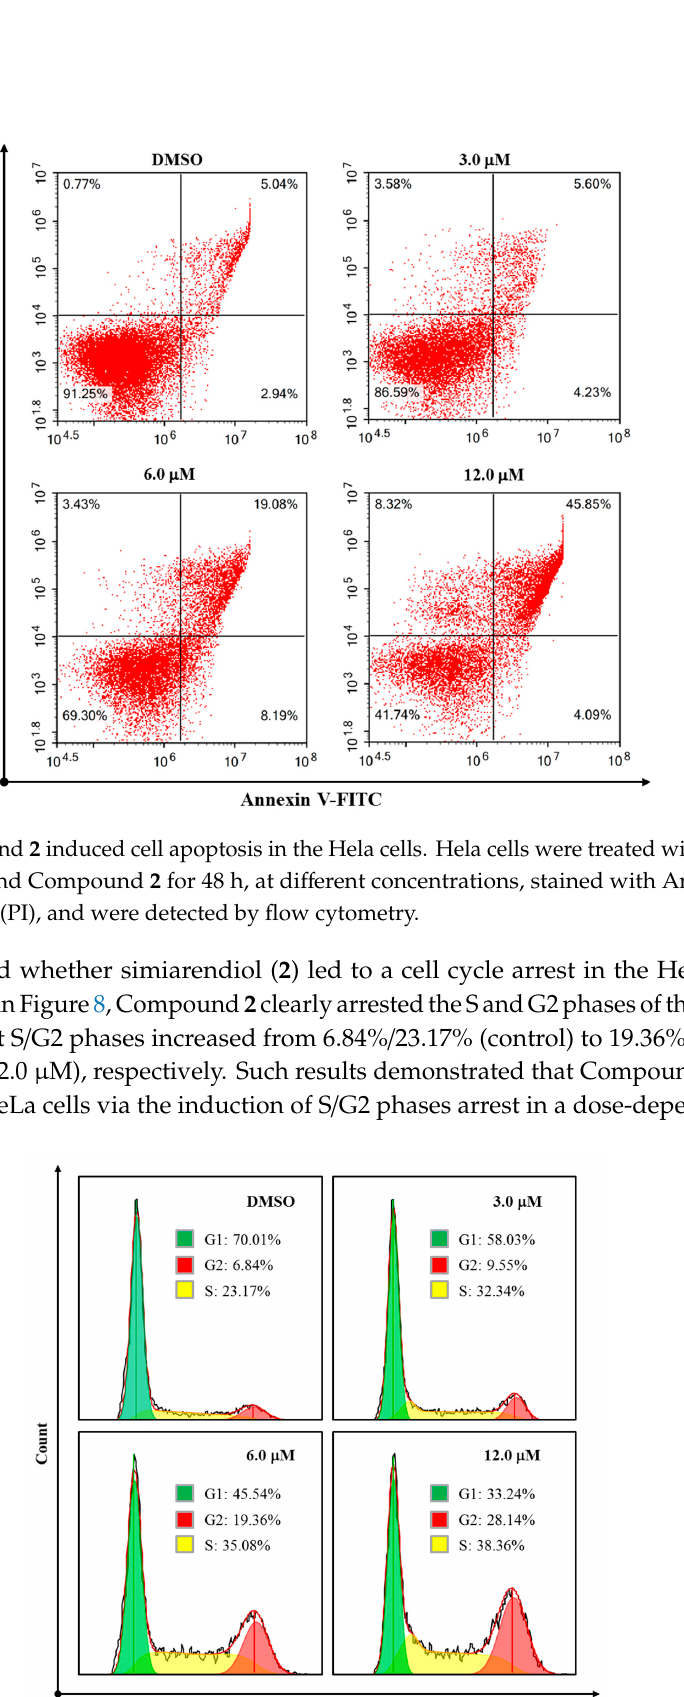
Figure 6. Morphological observation for Hela cells. HeLa cells were treated with vehicle control (DMSO) and Compound 2 at different concentrations for 48 h, stained with DAPI and viewed under a fluorescence microscope at a magnification rate of 200. Red arrows represent the altered nuclear morphology in a dose-dependent manner.